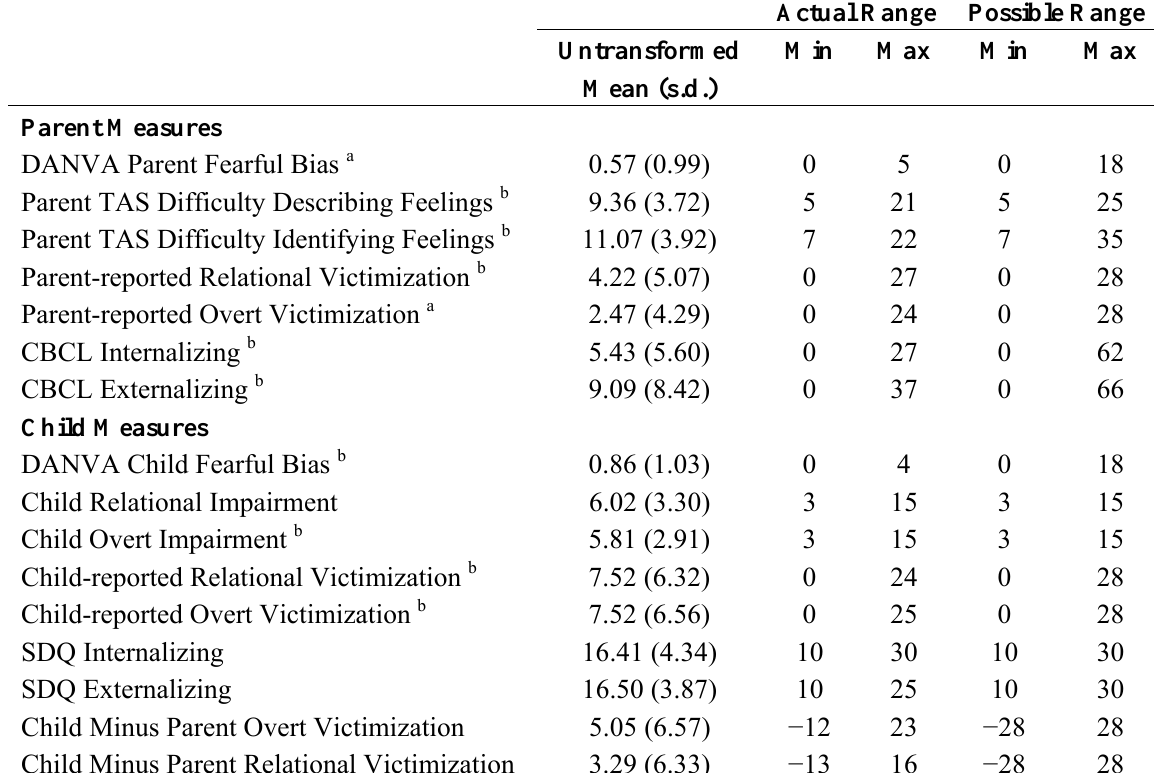
Table 1. Descriptive Statistics for All Study Variables Prior to Transformation.